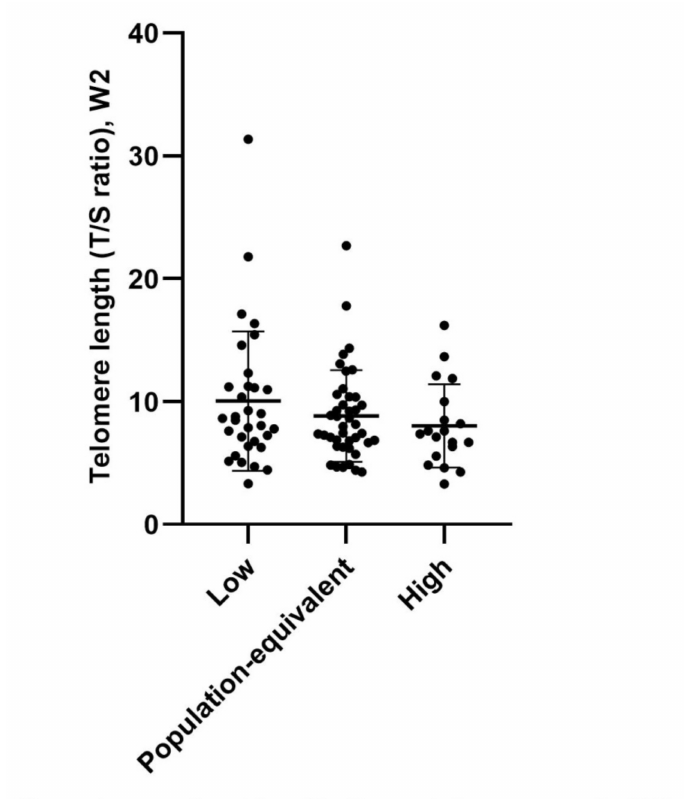
Figure 1. Telomere length in W2 among adolescents by different levels of exposure to parent- perceived family financial pressure in